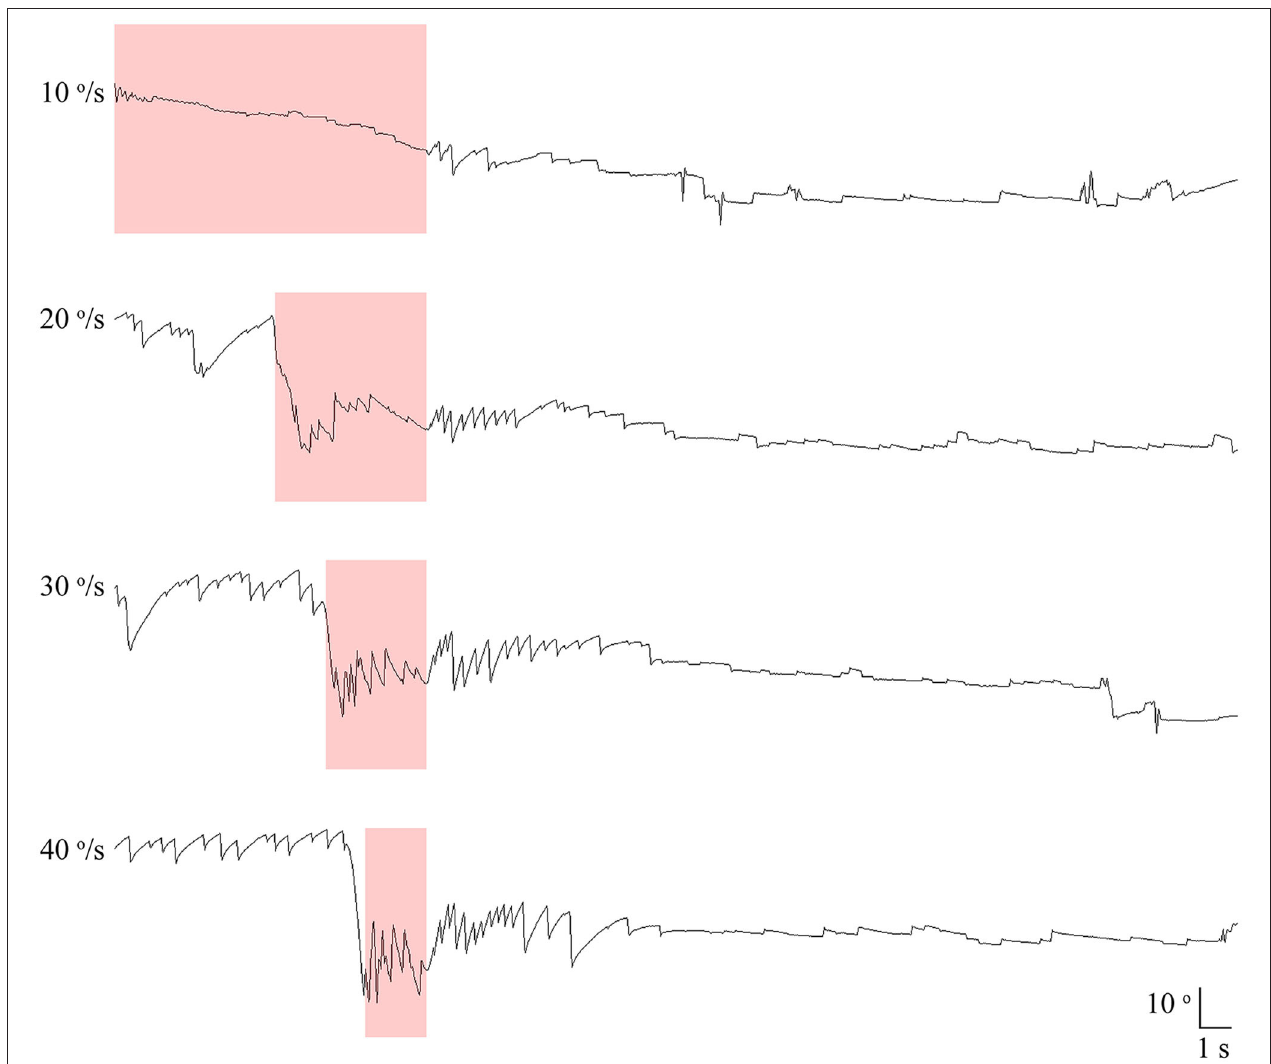
FIGURE 2 | Recording of paroxysmal downbeat nystagmus induced during motorized rotation chair test at four different rotation velocities in patient 21. The intensity of induced downbeat nystagmus increased as the rotation velocity was escalated from 10 to 40 ◦ /s. The paroxysmal downbeat nystagmus was followed by a small upbeat nystagmus. Only the vertical eye motion is presented and the shaded areas in pink indicate the period of positioning. Upward deflection denotes upward eye motion in each